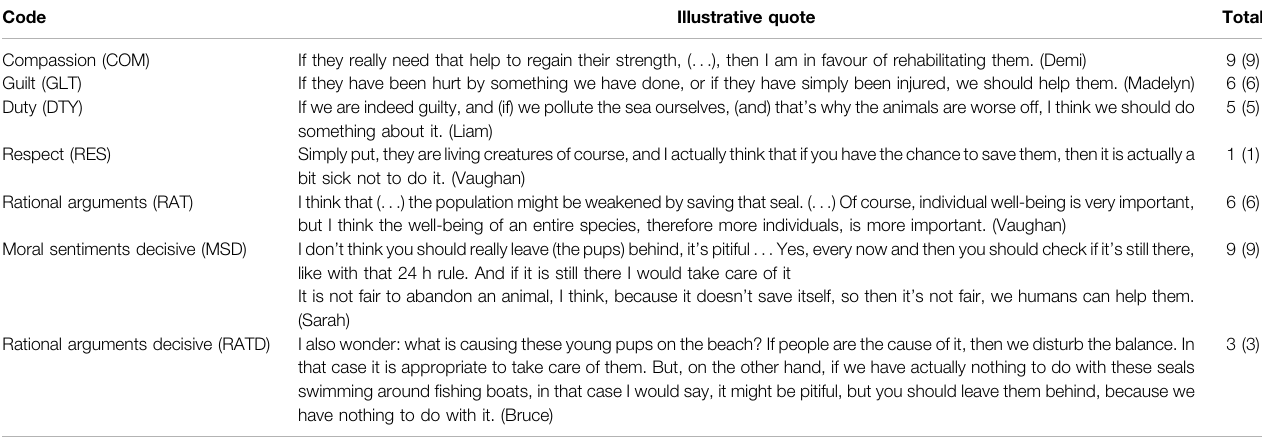
TABLE 8 | Students ’ morality regarding their moral character ( n (cid:1)